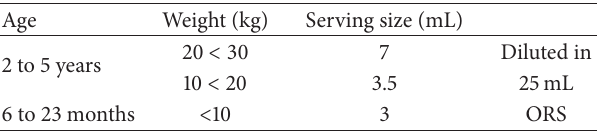
Table 1: Serving sizes of LifeDrops solution or distilled water provided to subjects in either the study or control